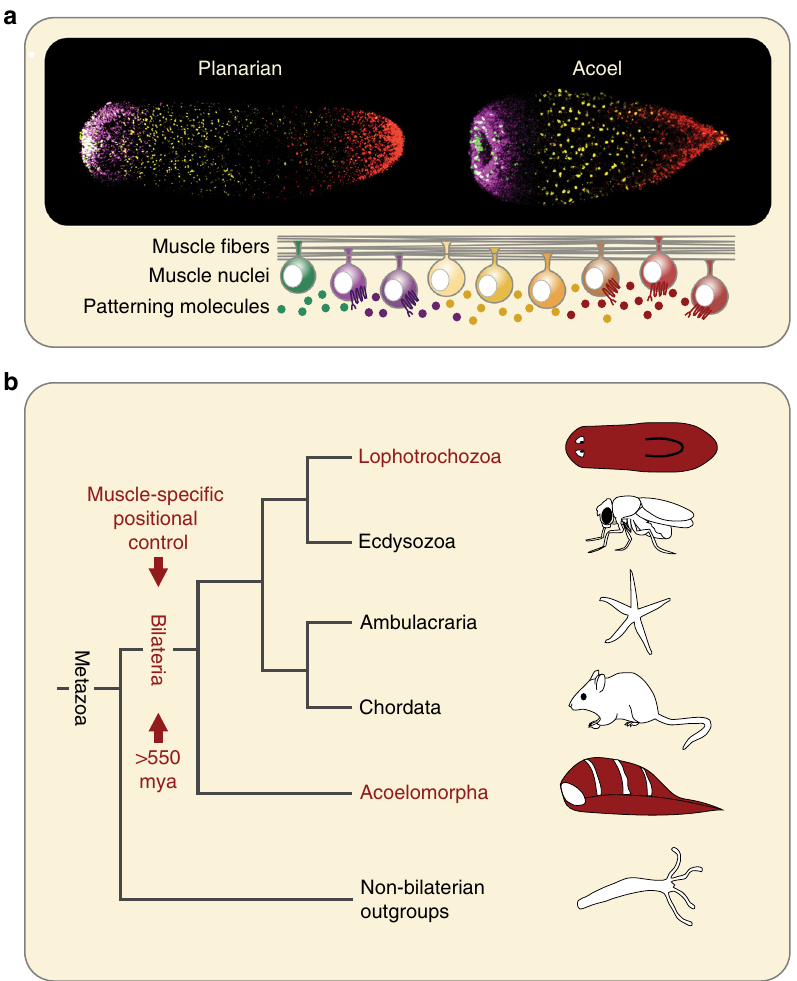
Fig. 6 Model for evolution of muscle-speci fi c positional control. a Both planarians and Hofstenia demonstrate muscle-speci fi c expression of positional control genes, despite divergence of over 550 million years. b Muscle-speci fi c expression of PCGs in both lophotrochozoans and acoels suggests that it arose as a mechanism of regenerative patterning at the base of the Bilateria, over 550 million years